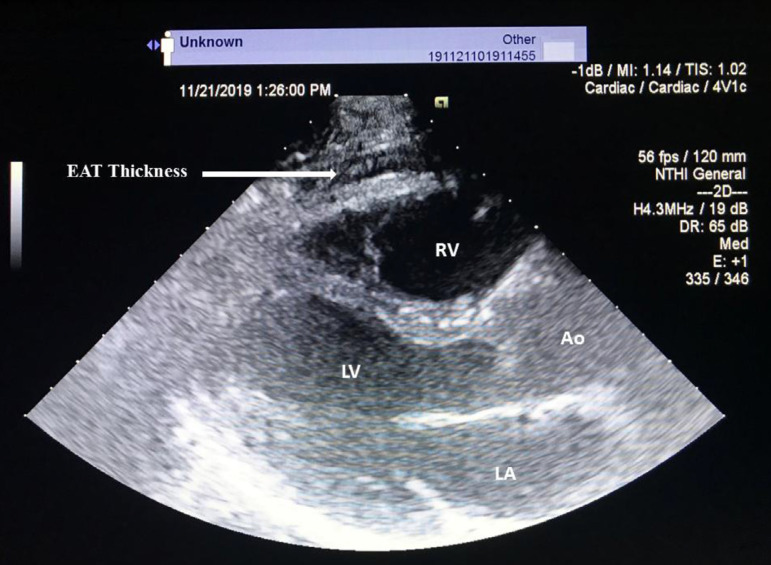
EAT was identified as an echo-free space between external myocardium and visceral pericardium from the parasternal long-axis view and was measured perpendicularly in front of the right ventricular free wall at end-diastole; AO=aorta; LA=left atrium; LV=left ventricle; RV=right ventricle